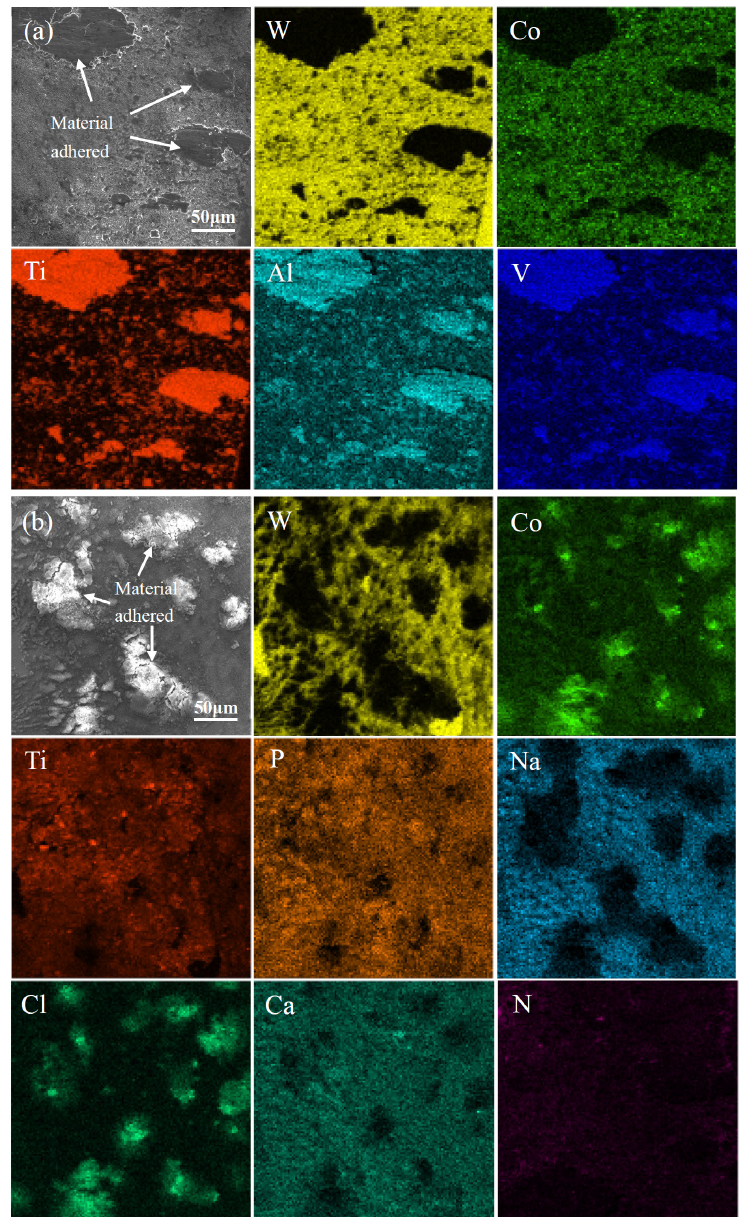
Figure 11. The worn surface images of the counter-body ball against ( a ) the Ti6Al4V substrate and ( b ) the coating modified with CeO 2 , and the corresponding EDS surface scanning results.